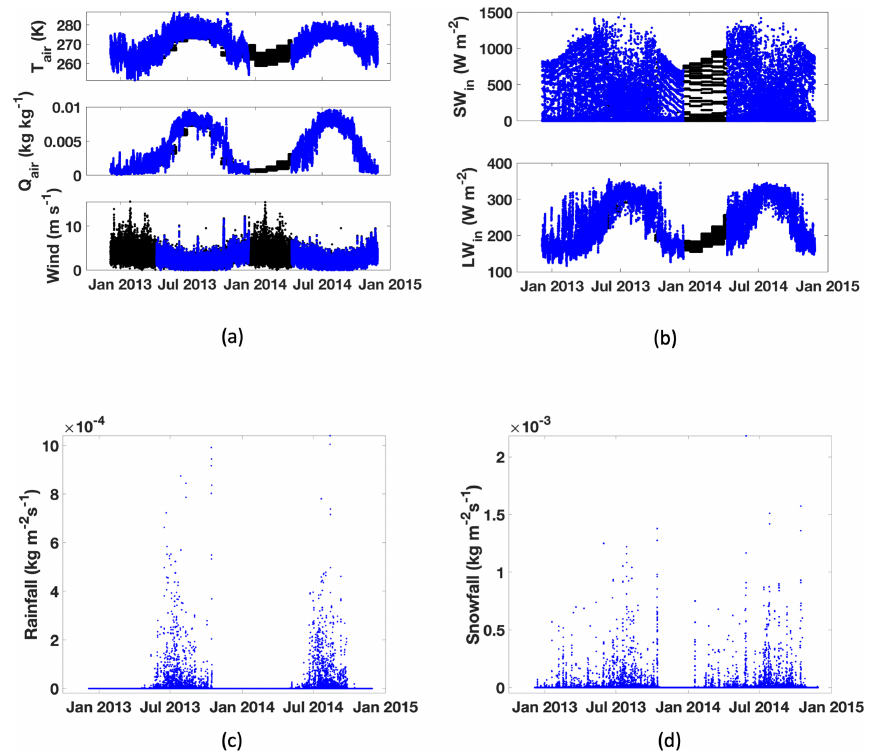
Figure 2. (a, b) Continuous half-hourly forcing data in black, with in situ data overlaid in blue. The gaps are apparent where the black data points are displayed; Sect. 2.3 describes the procedure used to assign these values. (c, d) The continuous precipitation dataset from Pyramid (interpolated half-hourly), with phase partitioned by T air at West Changri Nup glacier (top panel of a ). Note the different y axis scales on (c) and (d)